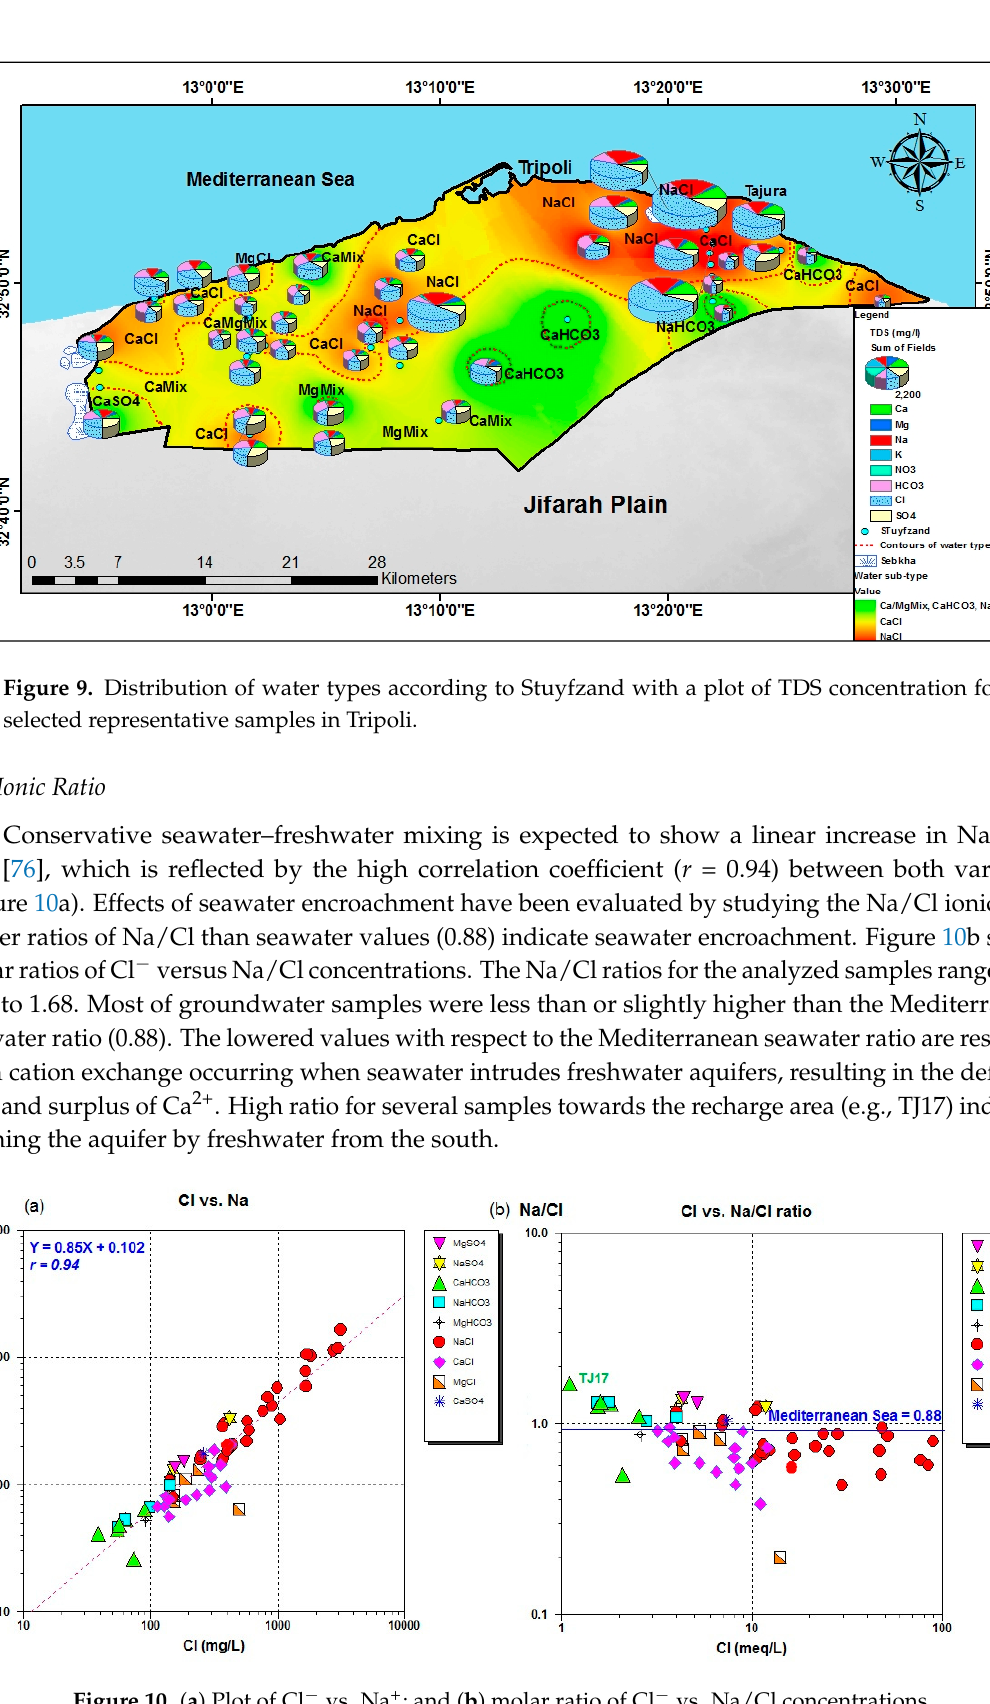
Figure 10. ( a ) Plot of Cl − vs. Na + ; and ( b ) molar ratio of Cl − vs. Na/Cl concentrations.